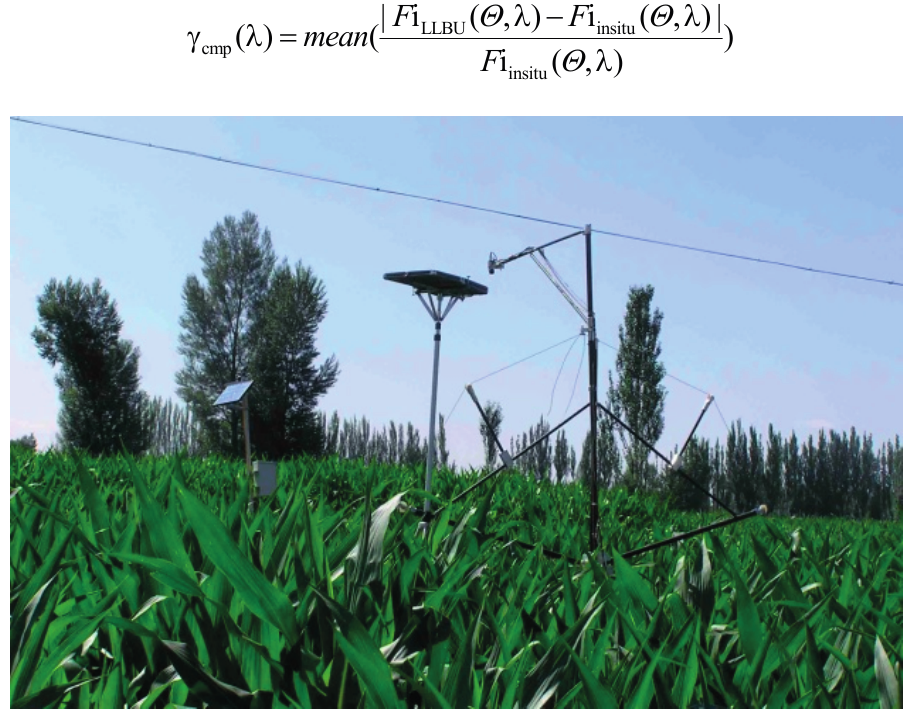
Figure 6. The scene of corn canopy multi-angular reflectance measurement .